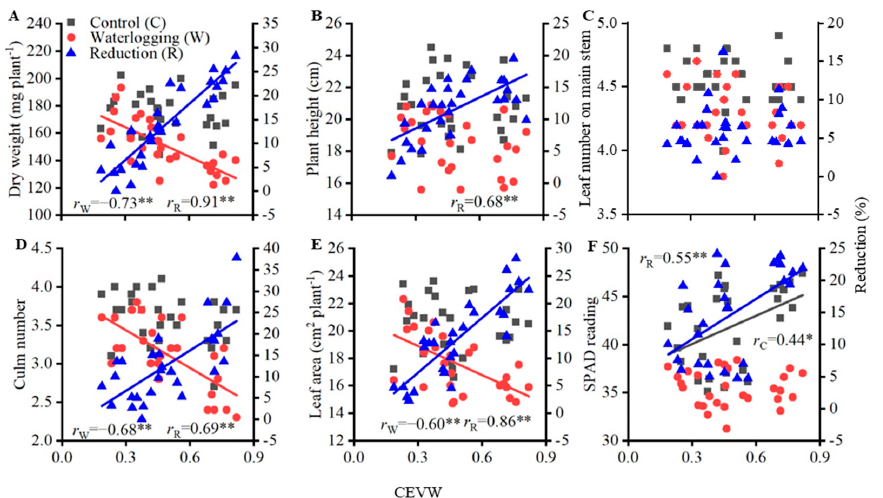
Figure 3. Relationships of the dry weight ( A ), plant height ( B ), leaf number on main stem ( C ), culm number ( D ), leaf area ( E ), and SPAD reading ( F ) of different cultivars under the control and waterlogging conditions and their percentage reduction caused by waterlogging relative to CEVW. * and ** indicate significance at the 0.05 and 0.01 probability levels, respectively.